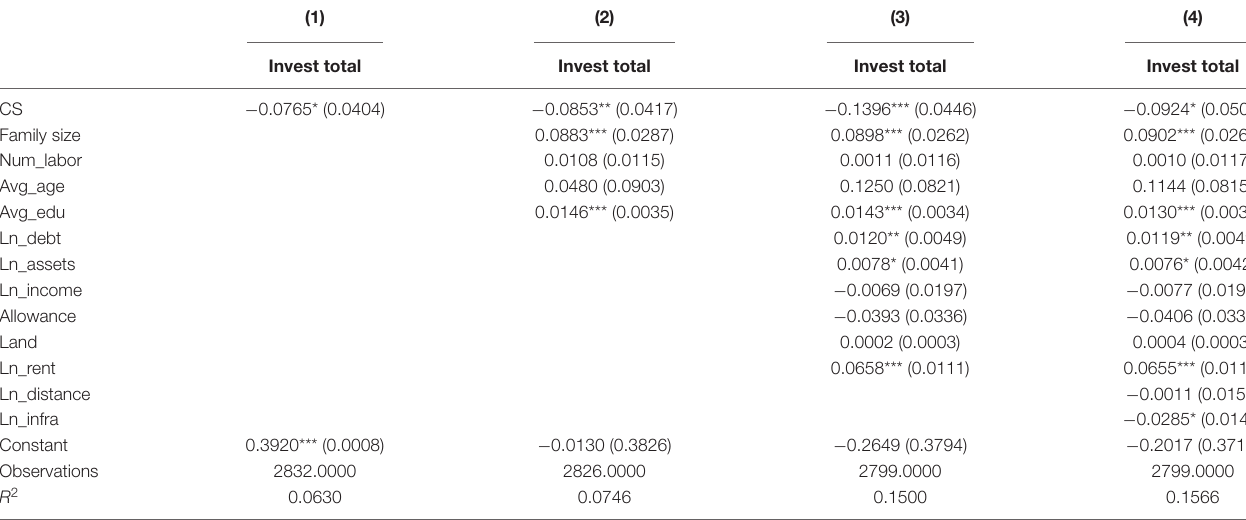
TABLE 3 | Regression results of the benchmark model between climate shocks and farmers’ agricultural investment.